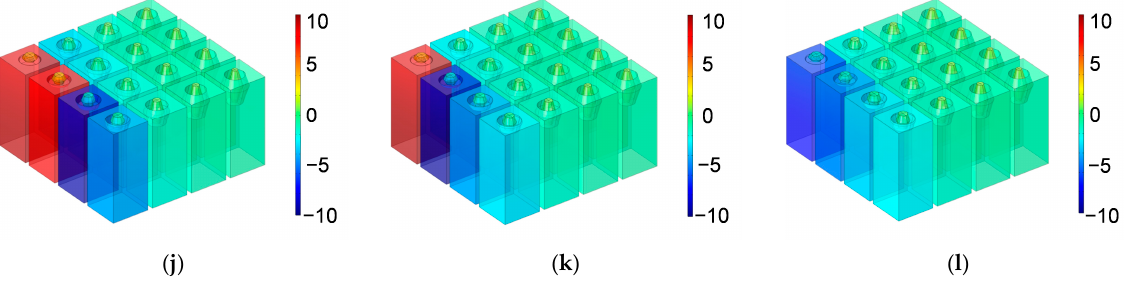
Figure 26. Distributions of acoustic pressure for multiple parallel connection HRs with embedded aperture, which consist of tangent sectional shape of olive and cross-sectional shape of round. ( a ) 400 Hz; ( b ) 420 Hz; ( c ) 450 Hz; ( d ) 500 Hz; ( e ) 550 Hz; ( f ) 600 Hz; ( g ) 650 Hz; ( h ) 700 Hz; ( i ) 750 Hz; ( j ) 800 Hz; ( k ) 850 Hz; and ( l ) 900 Hz.